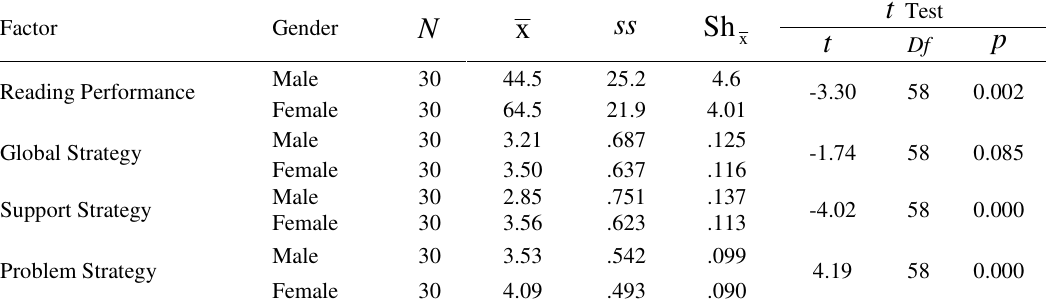
Table 1 Independent Samples T-Tests for Gender & Reading Performance, Reading Strategies and MI Factor